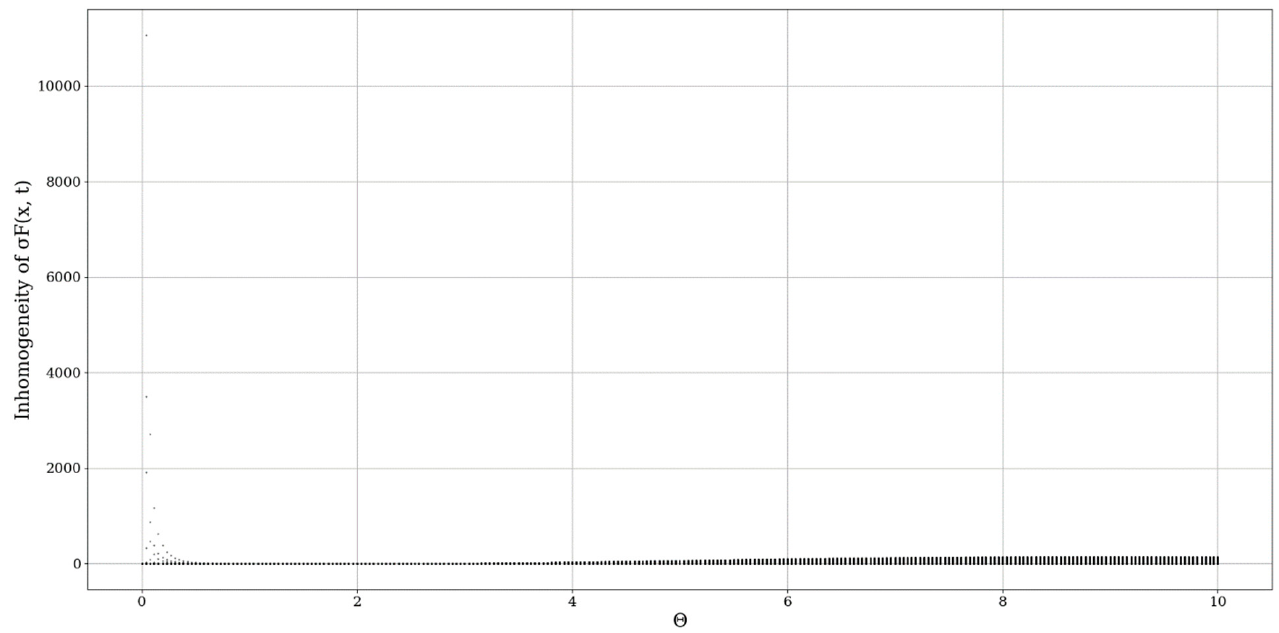
(cid:104)| σ | (cid:48) 2 (cid:105) example plot with θ as control parameter; ξ = 3; µ = 6. Figure 11. 〈|σ (cid:2890) (cid:3364)(cid:3364)(cid:3364)| (cid:4593)(cid:2870) 〉 example plot with θ as control parameter; ξ = 3 ; μ = 6 . Figure 11. F